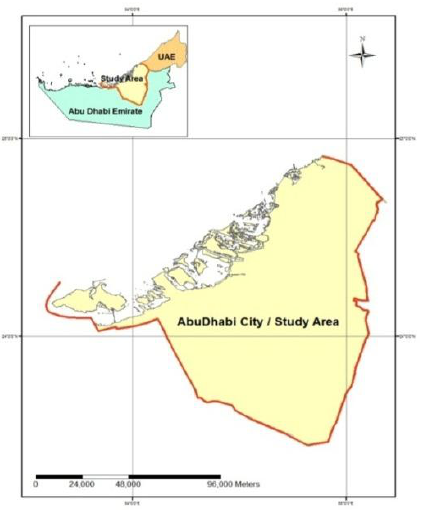
Figure 1. Study area: Abu Dhabi Municipal area, UAE